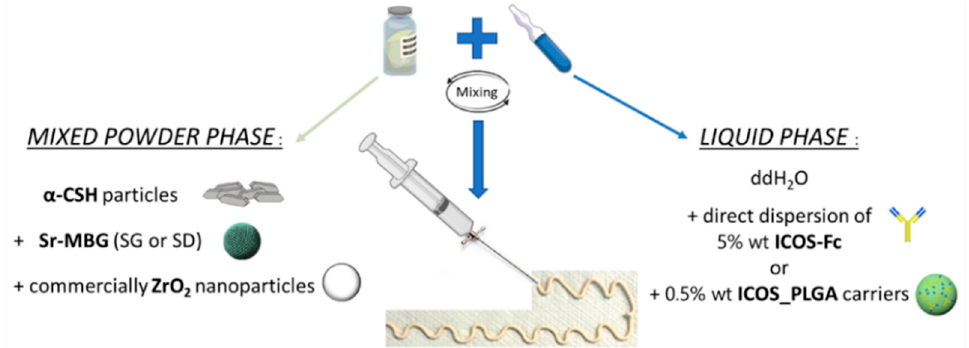
Figure 1. Schematic representation of the developed anti-osteoclastogenic